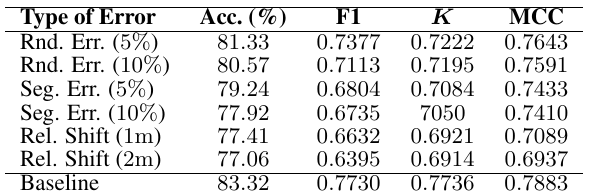
Table 4. Evaluation metrics for Vaihingen test set.